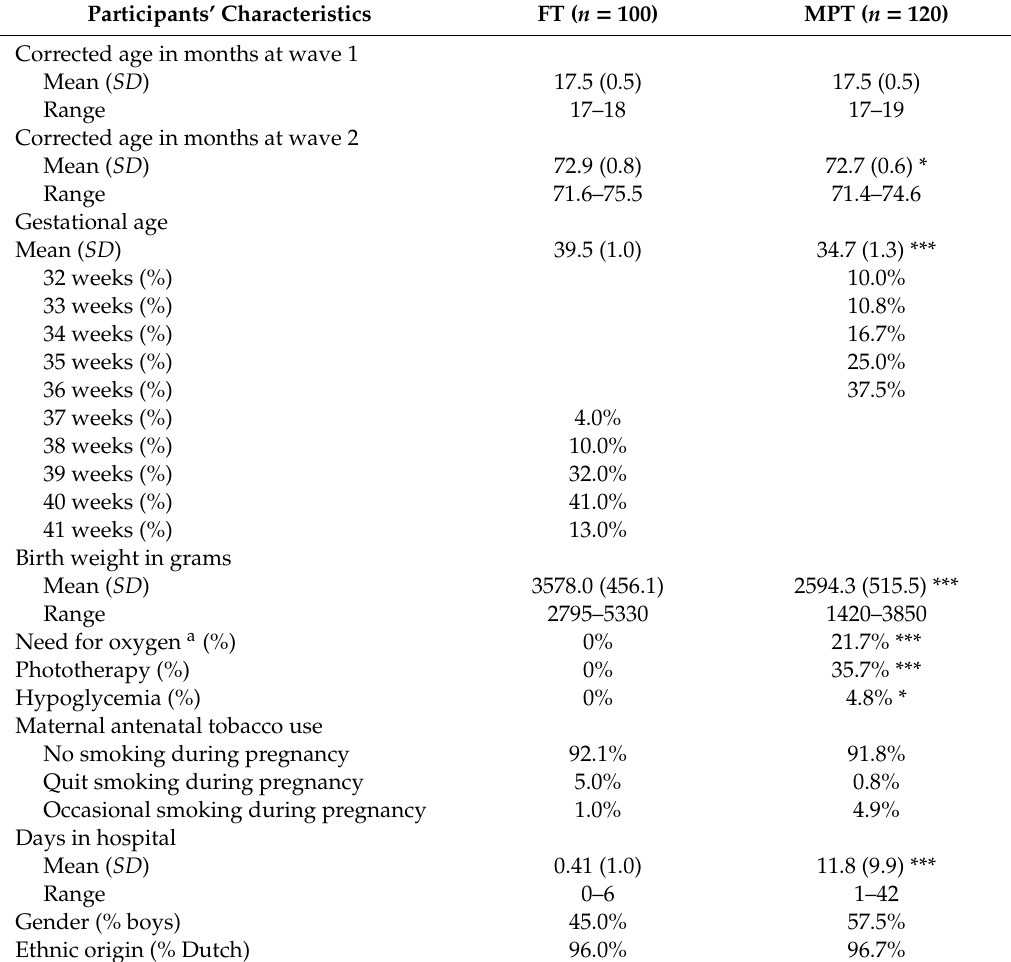
Table 1. Neonatal and demographic characteristics of the full term (FT) and moderately preterm (MPT)